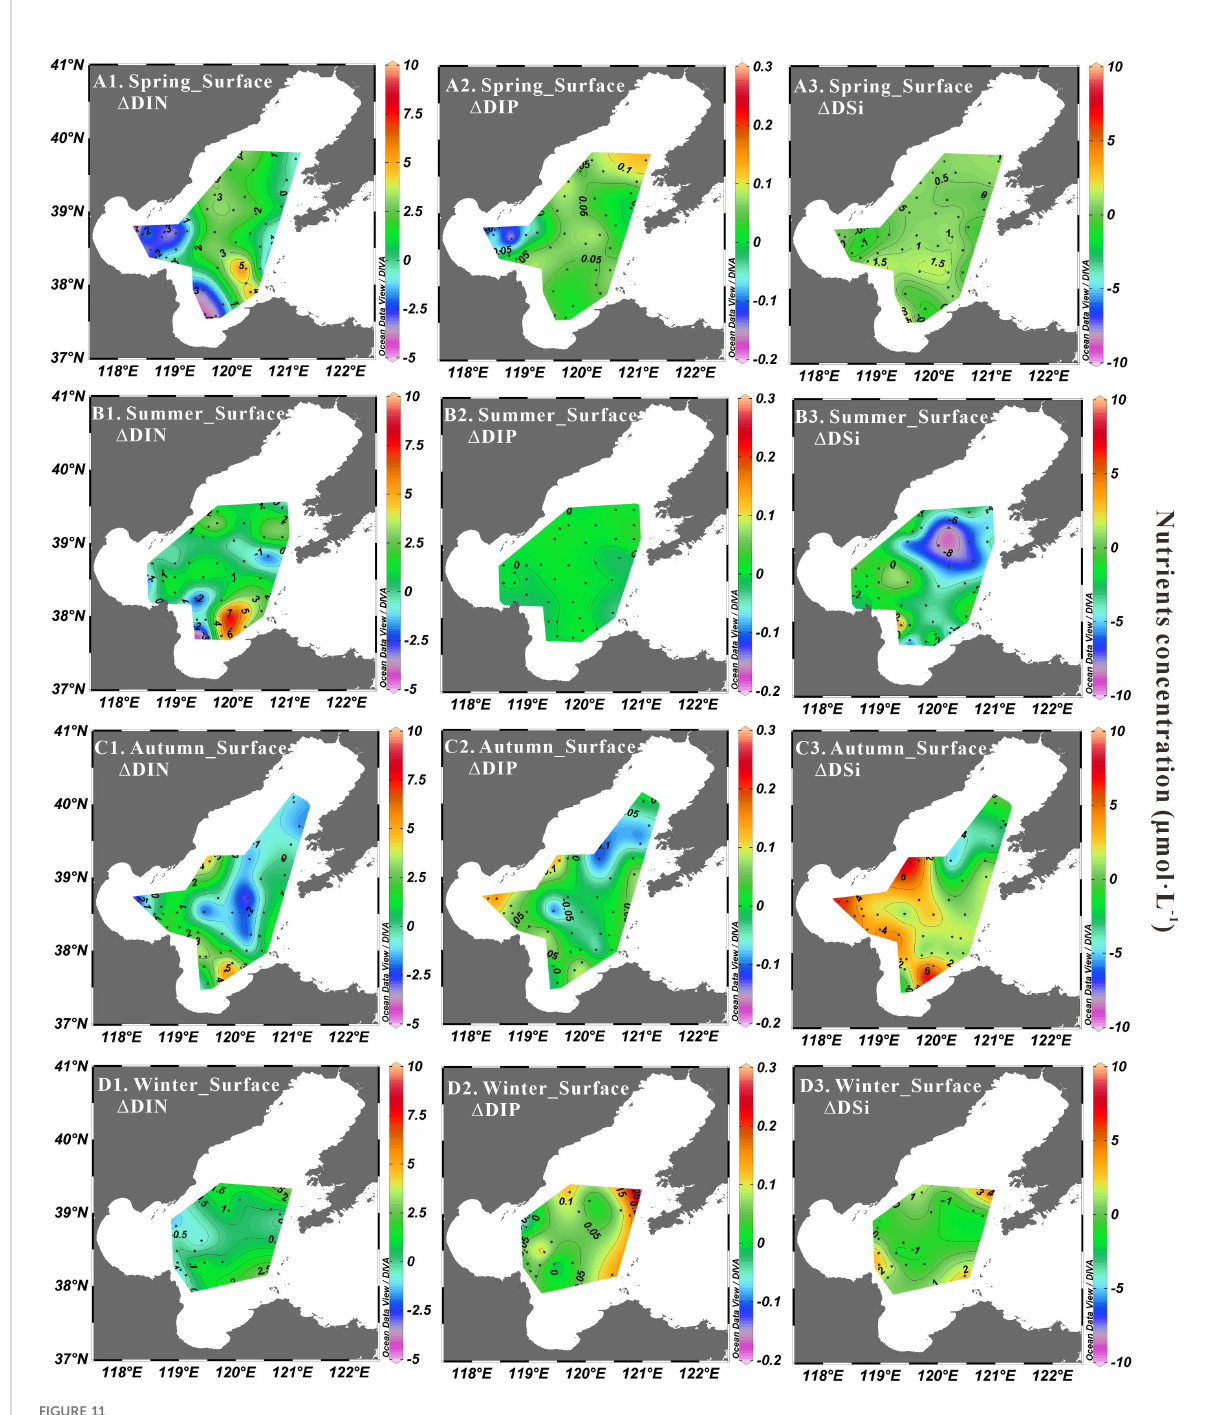
FIGURE 11 Nutrients deviation derived from the end-member mixing model at surface layer in spring (A1, A2, A3), summer (B1, B2, B3), autumn (C1, C2, C3) and winter (D1, D2,